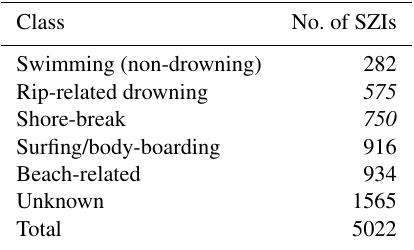
Table 2. Post-processed categories to distinguish between rip- related drownings and shore-break